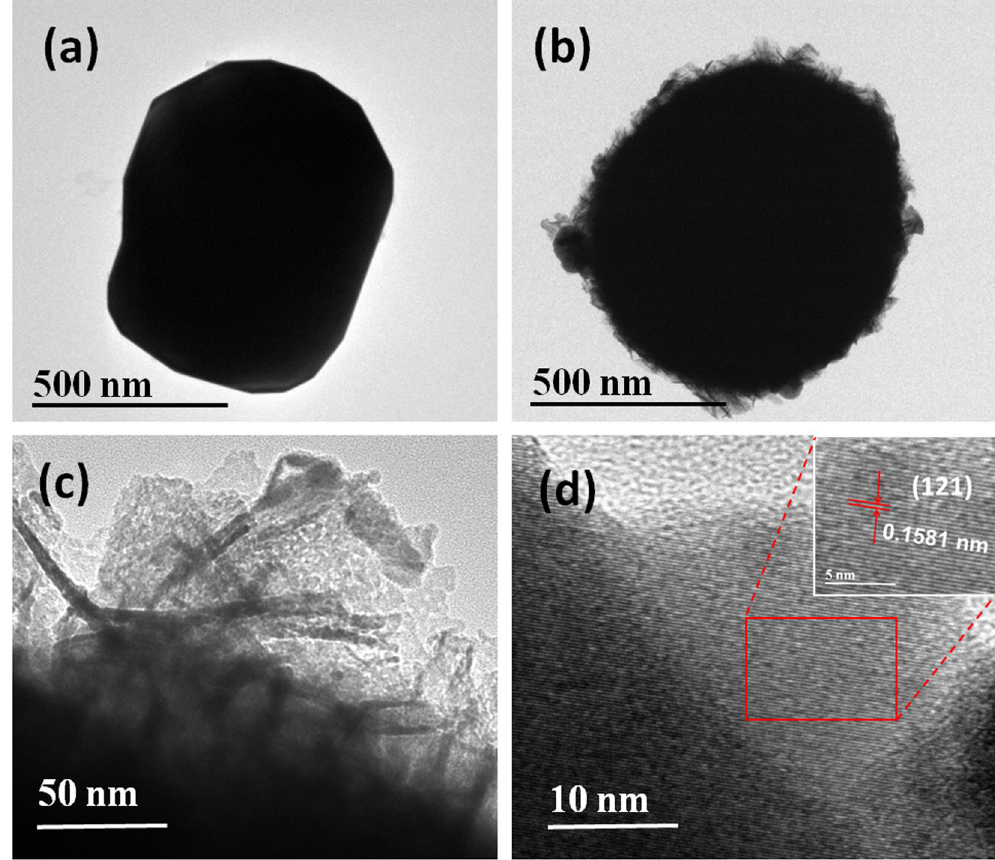
Figure 3. TEM images of ( a ) Bi 2 Fe 4 O 9 , ( b,c ) etched flower-like Bi 2 Fe 4 O 9 samples and ( d ) HRTEM images of the flower-like Bi